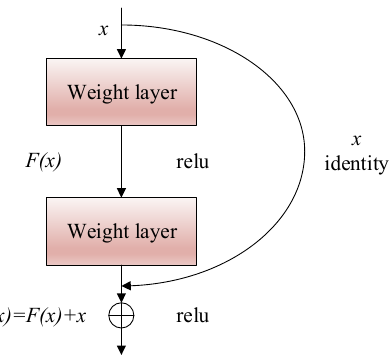
Figure 3. The structure diagram of the residual module.